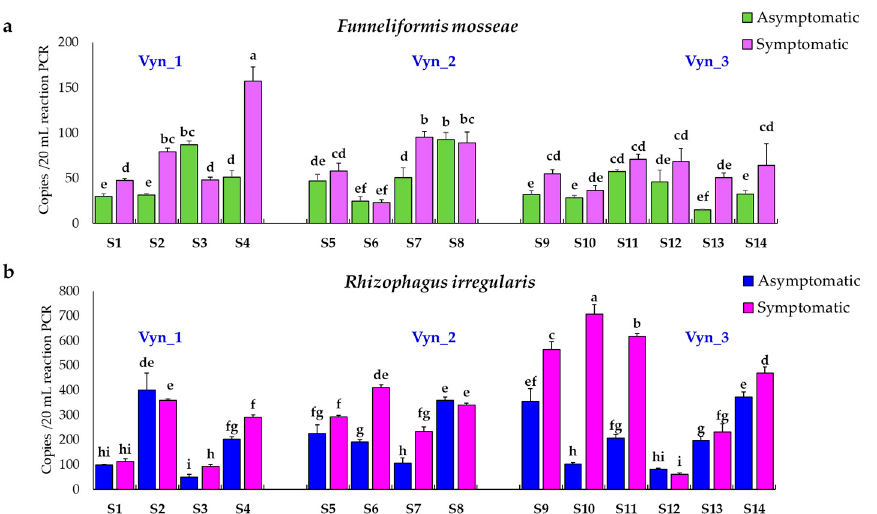
(Figure 7a). As for R. irregularis , in the roots from esca asymptomatic plants, the quantity ranged from 49 ± 11.3 copies/20 µ L (A3 plant), to 400 ± 69.8 copies/20 µ L (A2 plant), while in the roots from symptomatic plants the amount ranged from 92.5 ± 7.7 copies/20 µ L (I3 plant), to 358 ± 9.9 copies/20 µ L (I2 plant) (Figure 7b). Overall, the average copies of F. mosseae gene on Vyn_1 were 49.6 ± 4.1 copies/20 µ L on asymptomatic plants, and 82.8 ± 5.1 copies/20 µ L on symptomatic plants, respectively, while the corresponding numbers for the R. irregularis gene were 188.6 ± 22.6 copies/20 µ L on asymptomatic plants and 213 ± 9.1 copies/20 µ L on symptomatic plants, respectively.